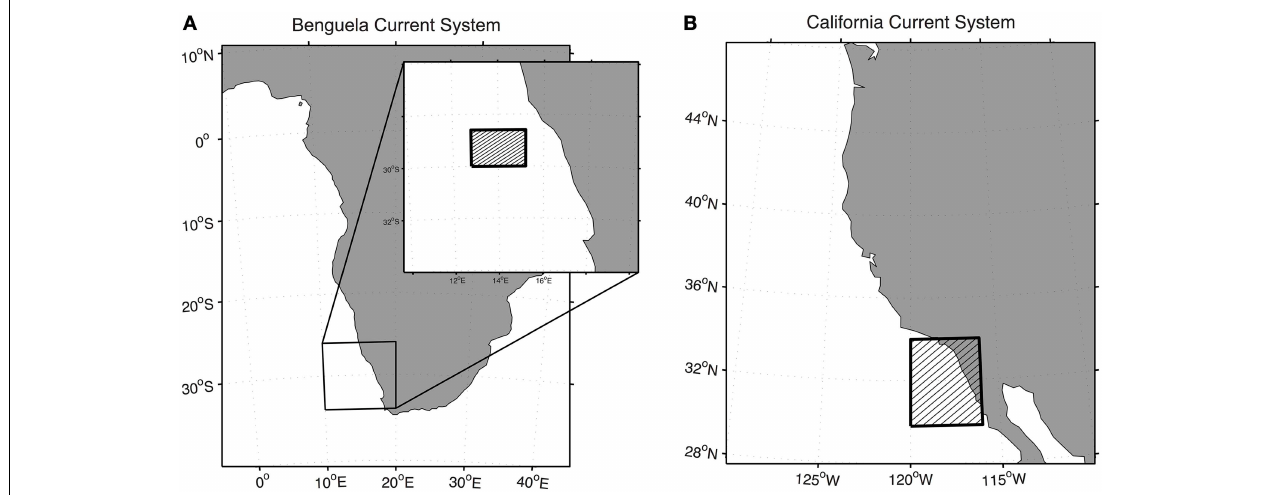
FIGURE 2 | Regions of study. (A) The Benguela Current upwelling system located along the southwest coast of Africa and (B) the California Current upwelling system along the U.S. west coast. For each region, the studies focused on the shaded area.